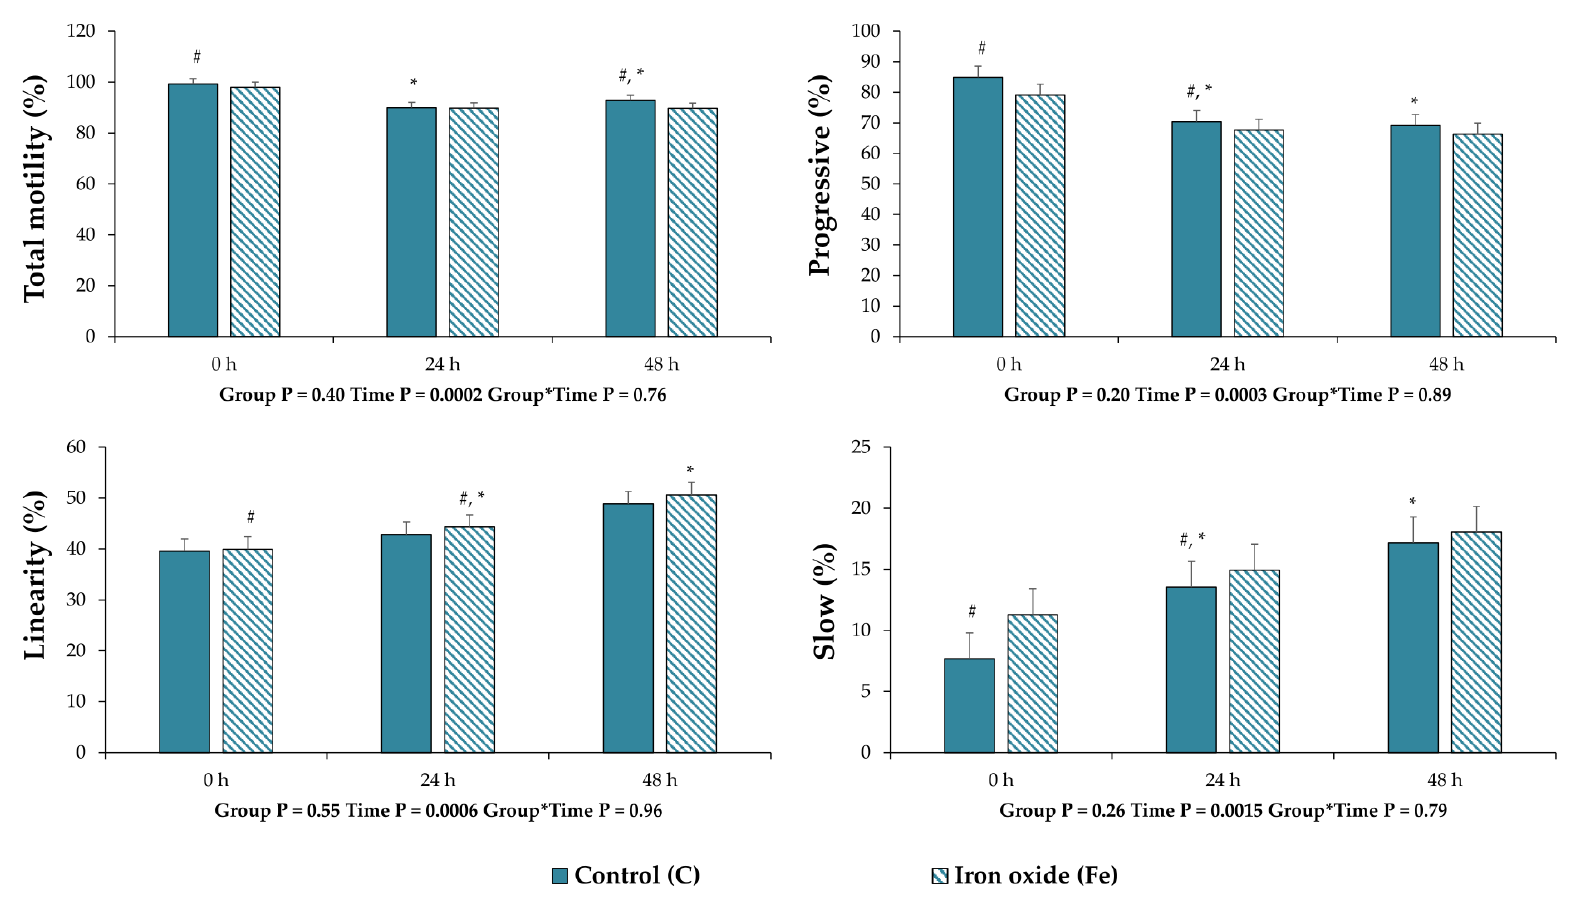
Figure 4. Sperm motility and kinematic parameters of extended boar semen samples at 0, 24 and 48 h of storage post treatment with Fe 3 O 4 nanoparticles (NPs). Control group (C): extended boar semen samples without any treatment; Iron oxide group (Fe): extended semen with Fe 3 O 4 NPs (0.192 mg Fe 3 O 4 /mL semen). All the values are expressed as mean ± standard error of the mean (SEM). Different symbols (#, *) denote significant differences between evaluation times within each experimental group.